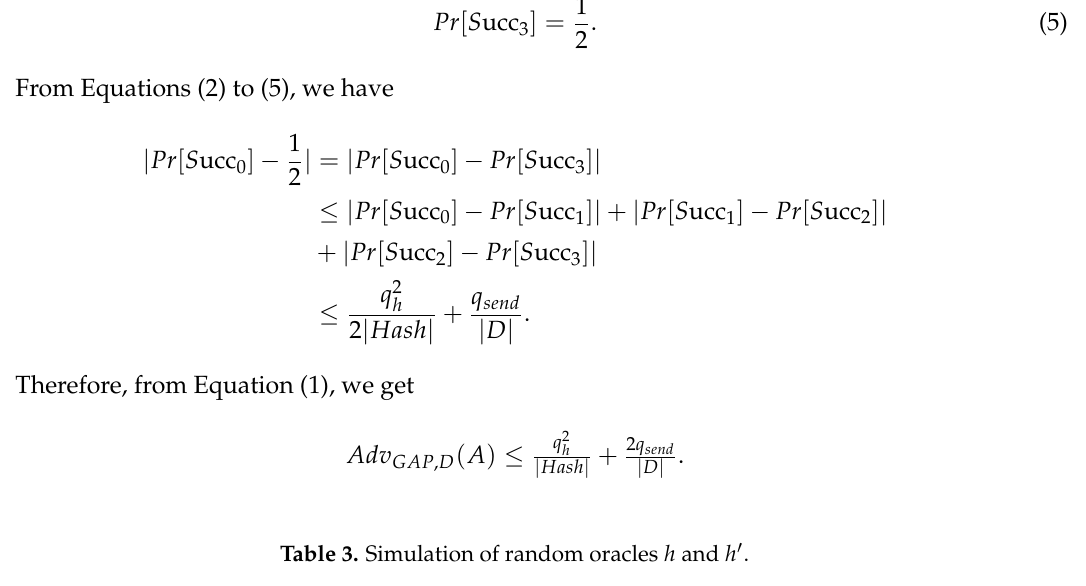
Table 3. Simulation of random oracles h and h (cid:48)